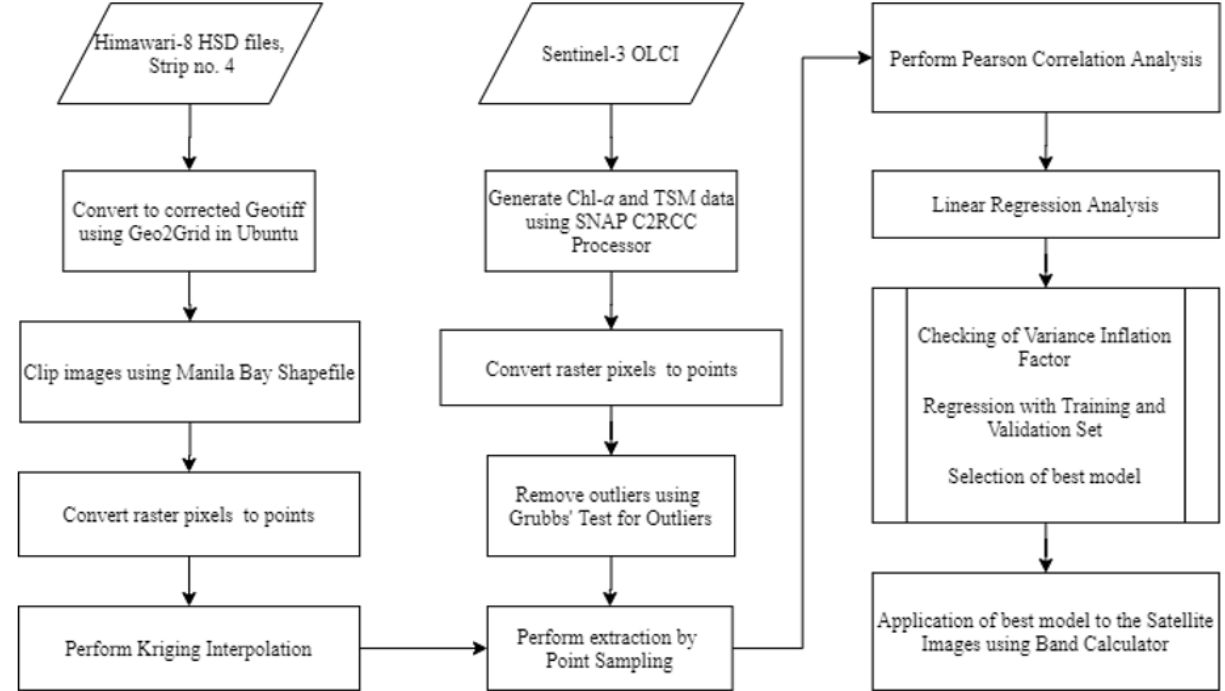
Figure 2. General methodology for Chl-a and TSM modelling using Himawari-8 and linear regression